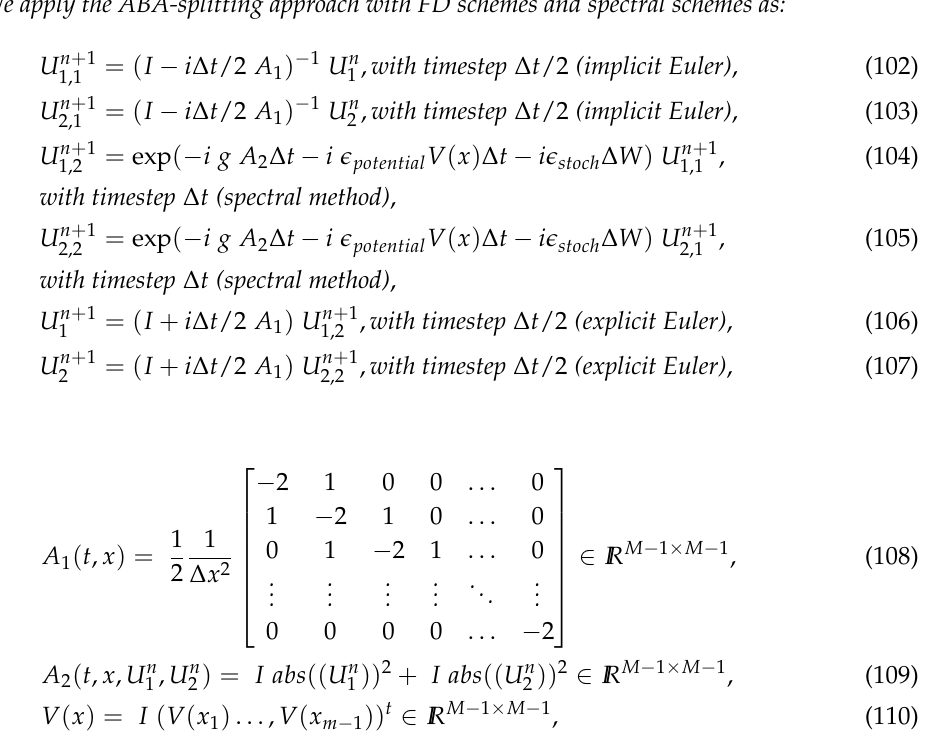
Algorithm 10. We apply the ABA-splitting approach with FD schemes and spectral schemes